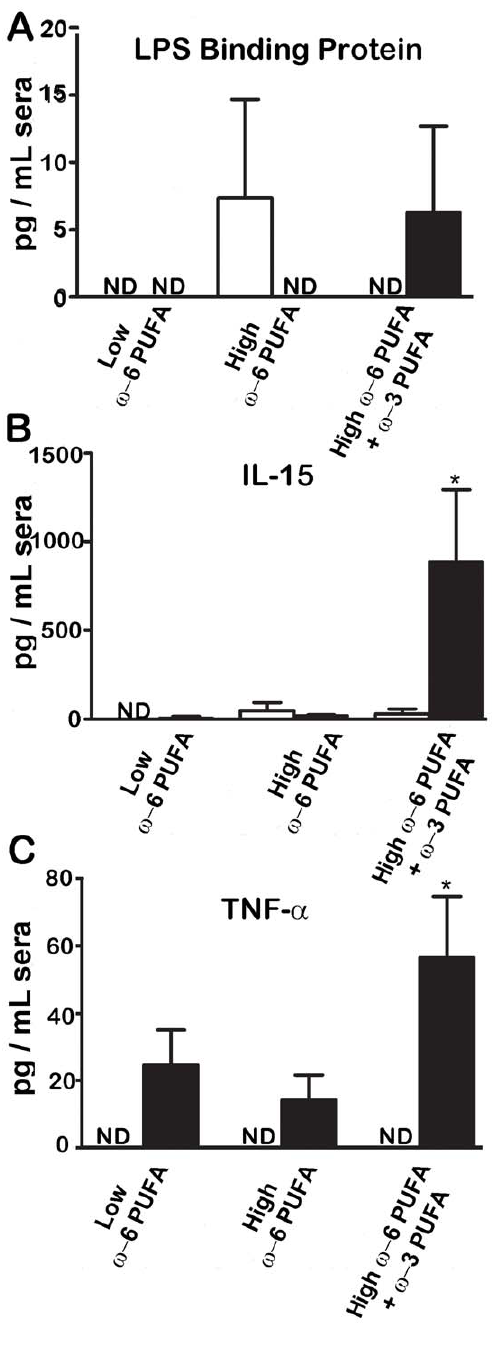
Figure 6. While v -6 PUFA rich diets resulted in the induction of LPS binding protein prior to infection, it was the v -3 PUFA supplemented diet that induced infection-induced septic responses. LPS binding protein, TNF- a and IL-15 were measured in sera from in mice that had been fed the various diets both before and after infection with C. rodentium . (*, P , 0.05).